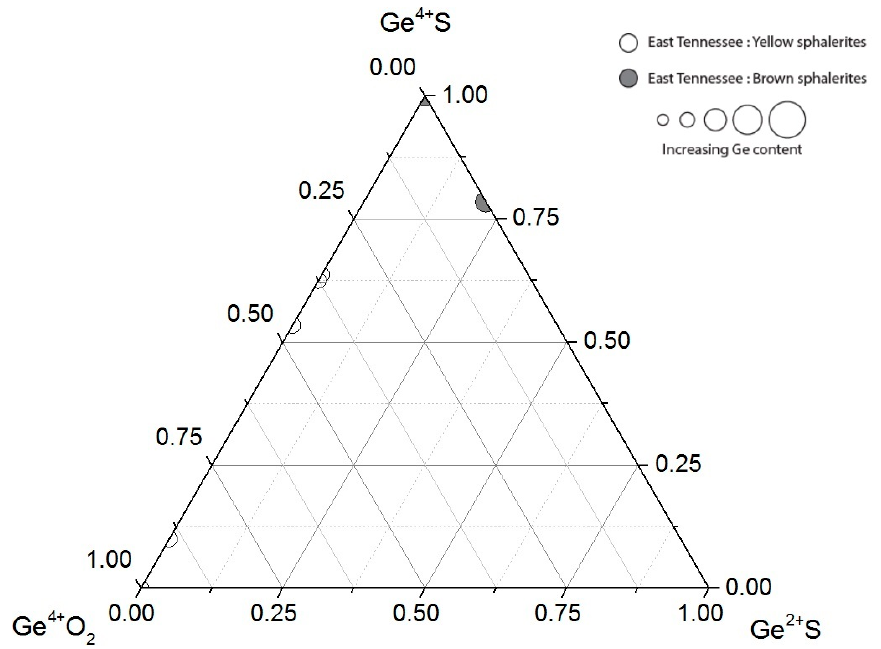
Figure 7. Ternary diagram for germanium configuration in samples from east Tennessee.